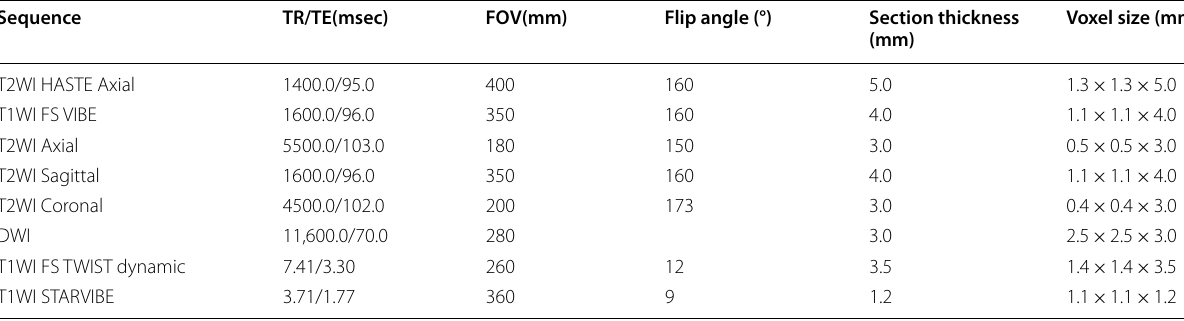
Table 1 Imaging parameters used for MRI